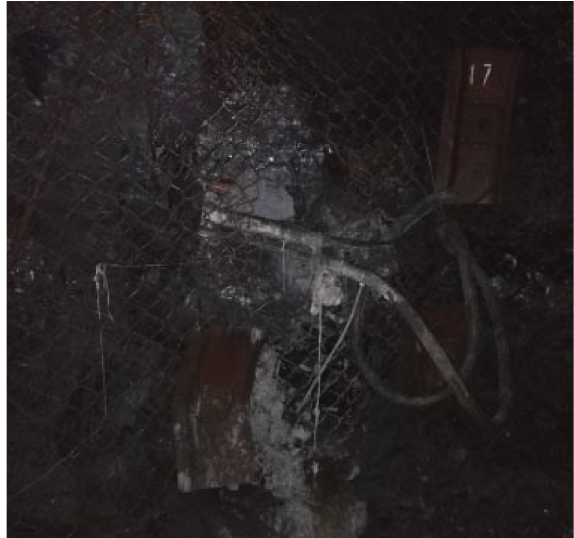
Figure 10: The entire hole was grouted.